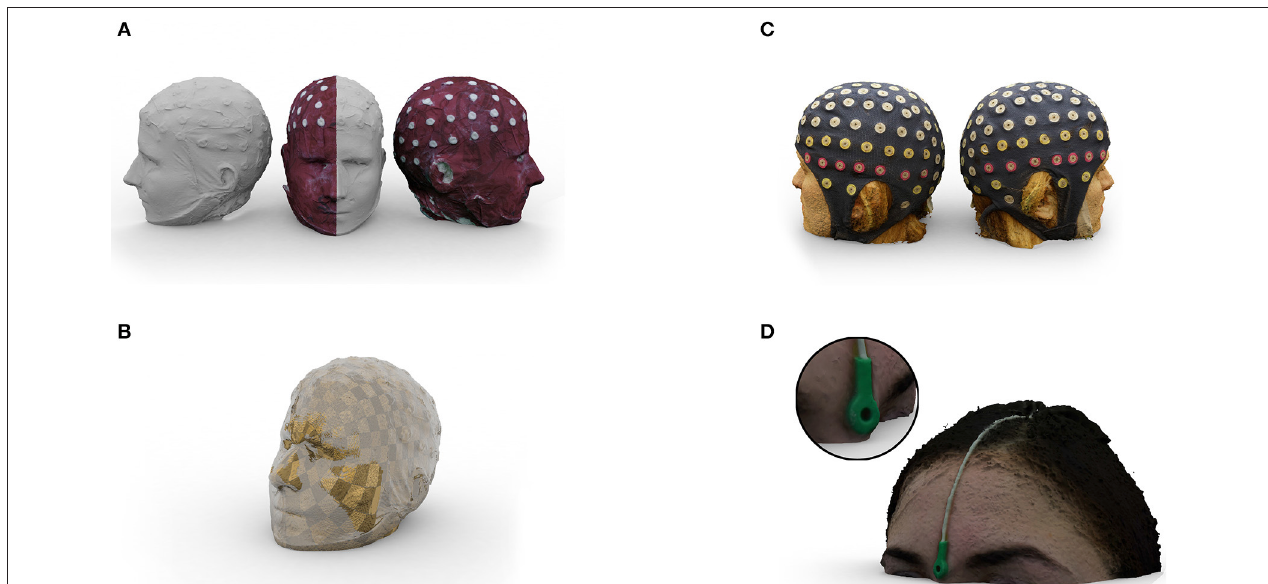
FIGURE 2 | (A) Half textured 3D mesh of the replica head generated from 56 photographs. The white surface shows the untextured mesh and the dark red surface represents the texture we added. (B) Coregistration of the photogrammetry-based 3D reconstruction to structural MRI. The checkerboard surface was generated from the scalp surface of the segmented MRI and the glassy surface from the photogrammetry-based 3D reconstruction. Both models were coregistered using janus3D . (C) Example of a mesh obtained from a human subject wearing an ANT Waveguard 128 EEG cap. (D) Example of a mesh obtained from a human subject with an electrode attached to the nasion as commonly used for MEG head position measurement. The meshes were generated from 43 (C) or 55 (D) photographs, applying the same reconstruction procedure.